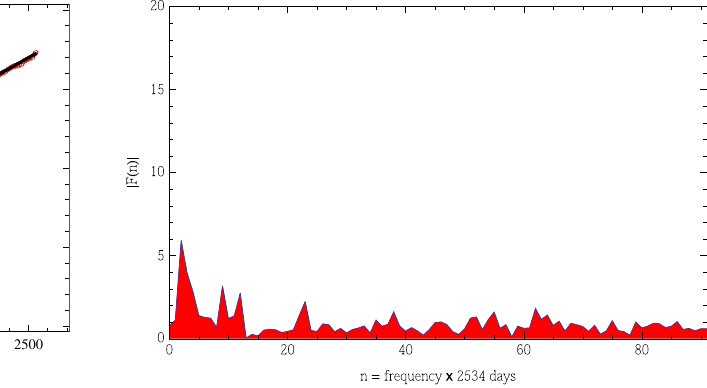
Fig. 1 Cumulative combined residuals of LARES, LAGEOS and LAGEOS 2 (shown in red), over about 7 years of orbital observations, after the removal the five main residual tidal signals. The solid black line is the fitted secular trend. The formal error of the fit is less than 0.001